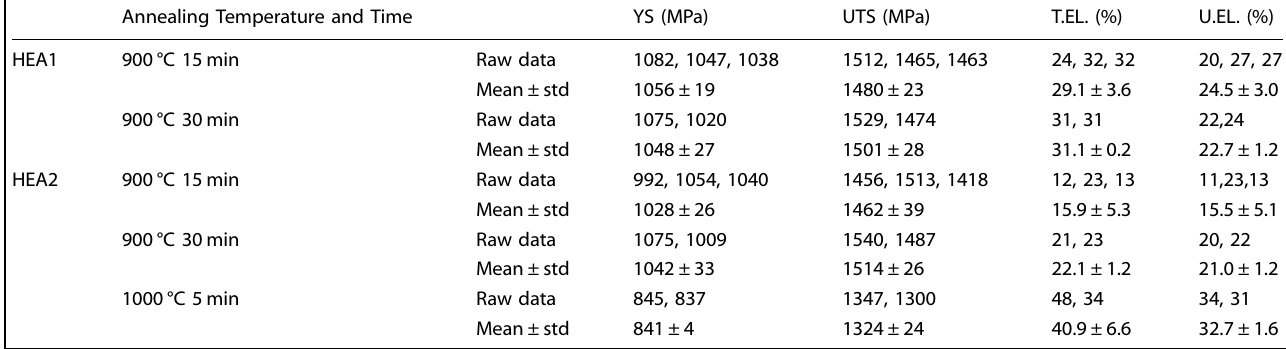
Table 3. Mechanical properties of HEA1 and